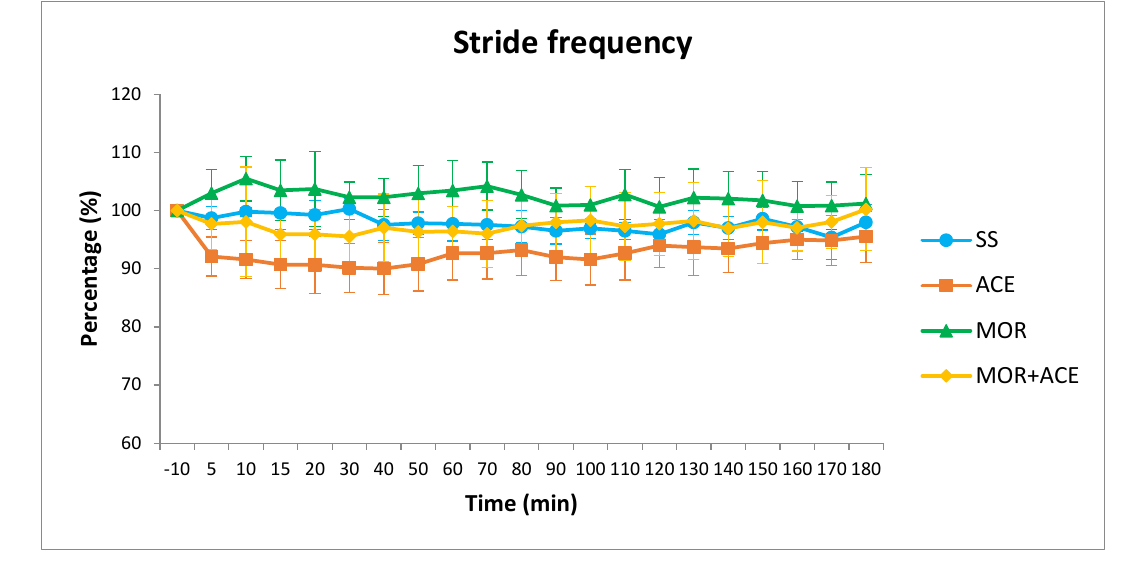
Figure 1. Stride frequency values (% ± SD) at baseline (-10 min) and at 5, 10, 15, 20, and then every 10 min (total period of 3 h) after IV injection (at 0 min) of 10 mL of sodium chloride (0.9%) (SS), 0.2 mg/kg of morphine hydrochloride solution diluted in sodium chloride (0.9%) to a volume of 10 mL (MOR), 0.02 mg/kg of acepromazine maleate diluted in sodium chloride (0.9%) to a volume of 10 mL (ACE), or a combination solution of 0.2 mg/kg of morphine hydrochloride and 0.02 mg/kg of acepromazine maleate diluted in sodium chloride (0.9%) to a volume of 10 mL (MOR + ACE).